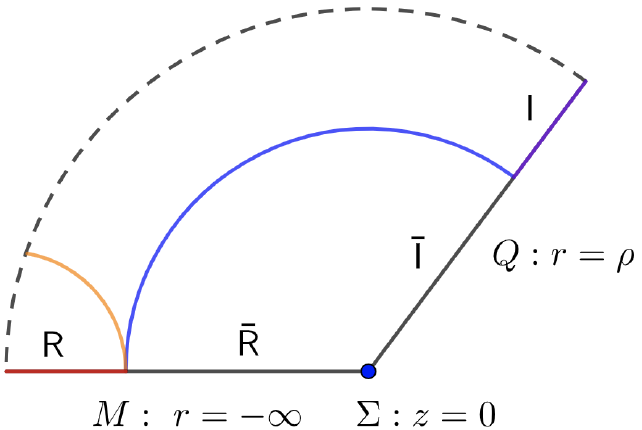
Figure 1 . The black-string geometry and its interpretation in black hole information paradox. Q is the KR brane with a gravitational black hole, and M is the AdS boundary with a non-gravitational black hole (bath). I and ¯ I denotes the island region (purple line) and its complement (black line) on the brane Q , R and ¯ R denotes the radiation region (red line) and its complement (black line) on the AdS boundary M , Σ is the defect (blue point) on the corner. Note that the island region I and radiation region R envelop the black-hole horizon on Q and M , respectively. For simplicity, we only show the regions outside the horizon. In bulk, the dotted line, blue, and orange lines indicate the horizon, RT surfaces in the island phase, and Hartman-Maldacena (HM) surface in the no-island phase at t = 0 ,